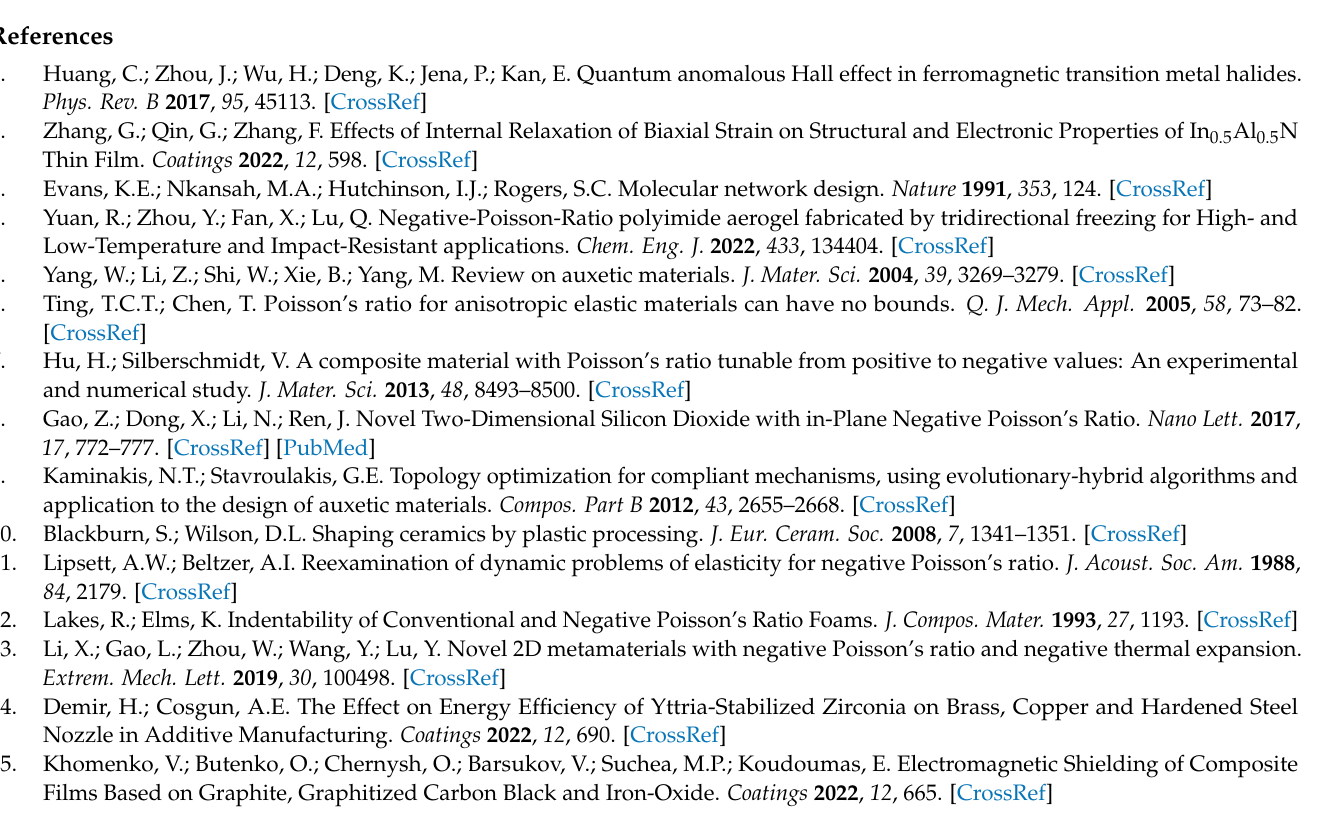
optical properties; Figure S2: MoS 2 (space group F43m); Figure S3: Comparison graphs of Young’s modulus and Poisson’s ratio for the four materials; Figure S4: Four negative Poisson’s ratio materials and their PDOS plots. (a) MoS 2 (space group P3m1). (b) MoS 2 (space group I42d). (c) MoSe